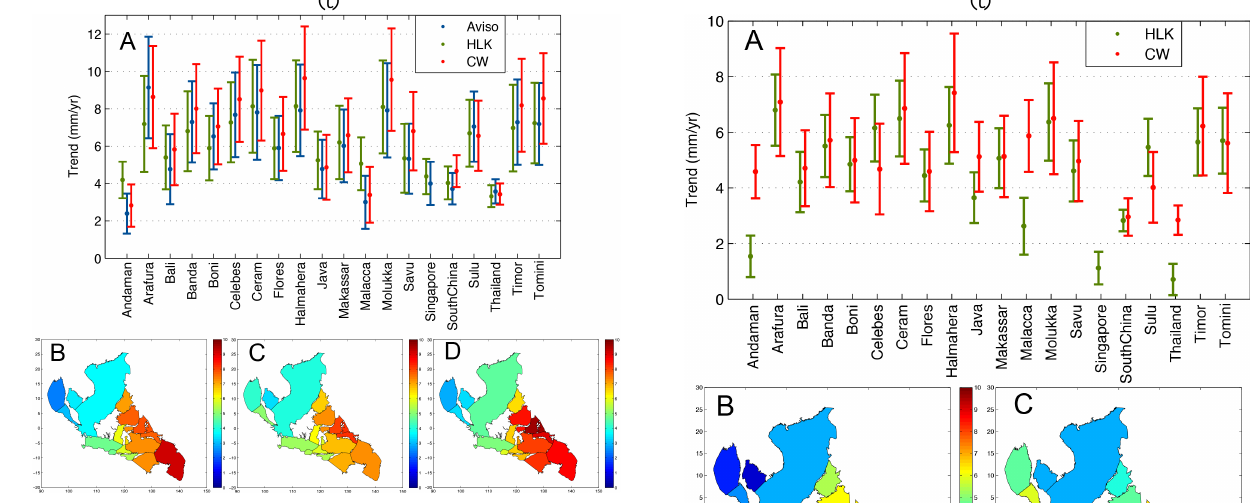
Figure 4. Southeast Asian sea average sea level trends over the 17- year satellite altimeter record from 1993 to 2009 shown plotted as trend values with standard error estimates (a) and as color maps for AVISO (b) , the HLK reconstruction (c) , and the CW reconstruction (d) . Reconstructed average trends agree with the AVISO values to within the estimated error.